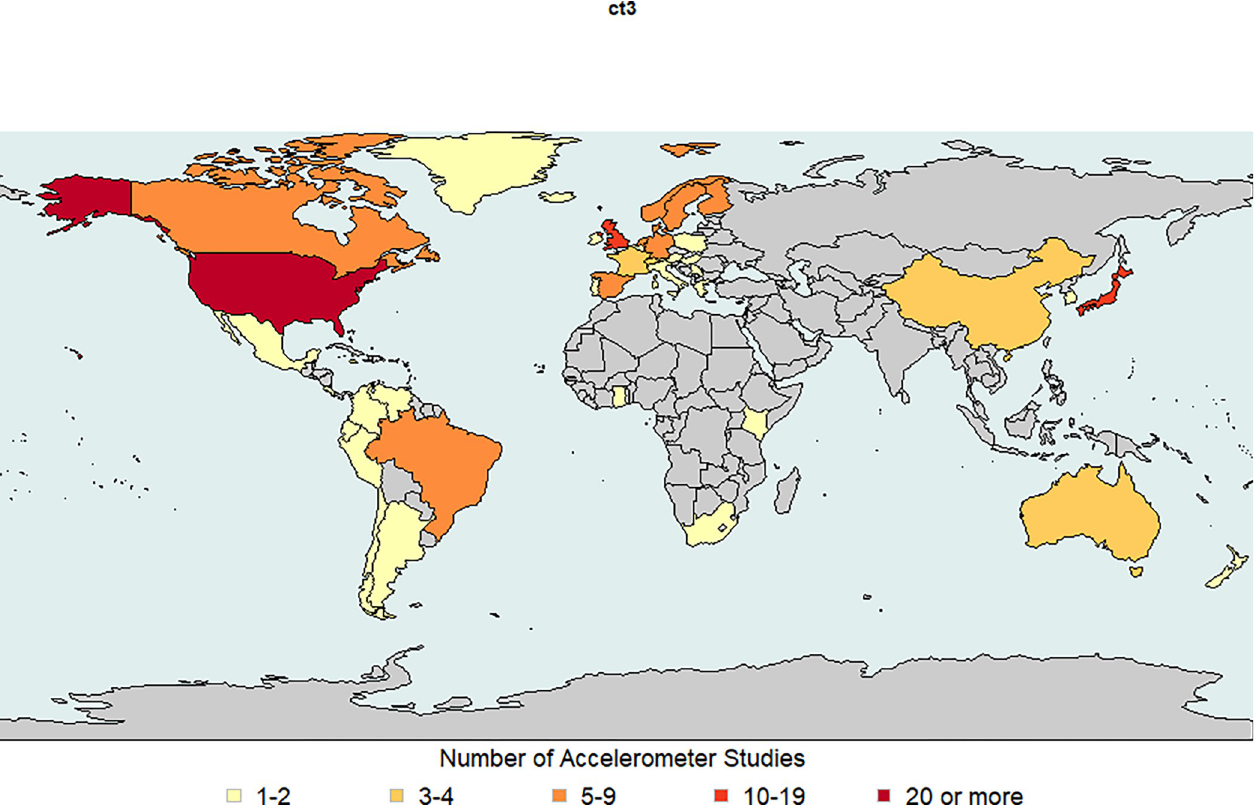
Fig 2. World map displaying the frequency of accelerometry studies found by country (n = 150). This map does not include the 5 distributed donor studies. England, Scotland, Wales, and Northern Ireland were mapped as the United Kingdom. Republished from [26] under a CC BY license, with permission from Dr. Andy South, original copyright